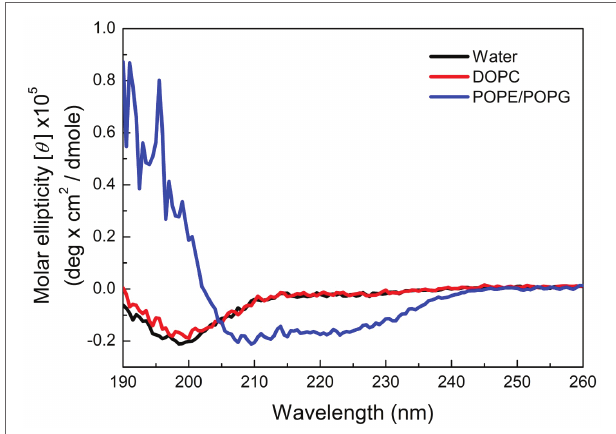
FIGURE 3 | CD spectra of pepD in water (black) and in the presence of the DOPC liposomes (red) and the POPE/POPG liposomes (blue).